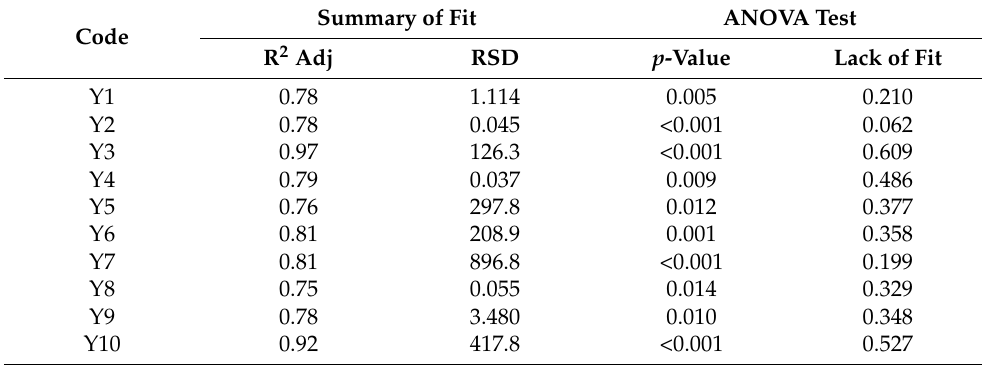
Table 5. Quality of fit (R 2 adjusted and RSD) and the ANOVA test.